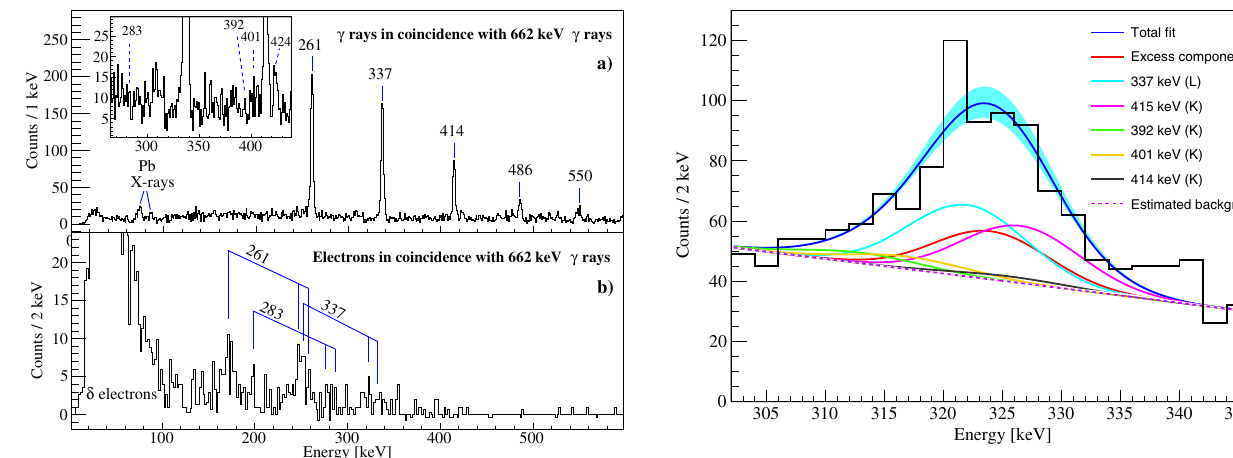
Fig. 7 Close-up of the recoil-gated, α -tagged electron energy spectrum ! 2 þ transition. Recoil- around 325 keV. The total fi t (blue) consists of components determined 2 1 from the measured γ -ray intensities and the excess electrons are associated ! 4 þ with the 4 þ transition. Components extracted from the observed γ 1 2 rays are labelled according to transition energies and electron shells of origin. The uncertainty of the total fi t at the 1 σ level is shown with a light blue band and the purple dashed line illustrates the extracted